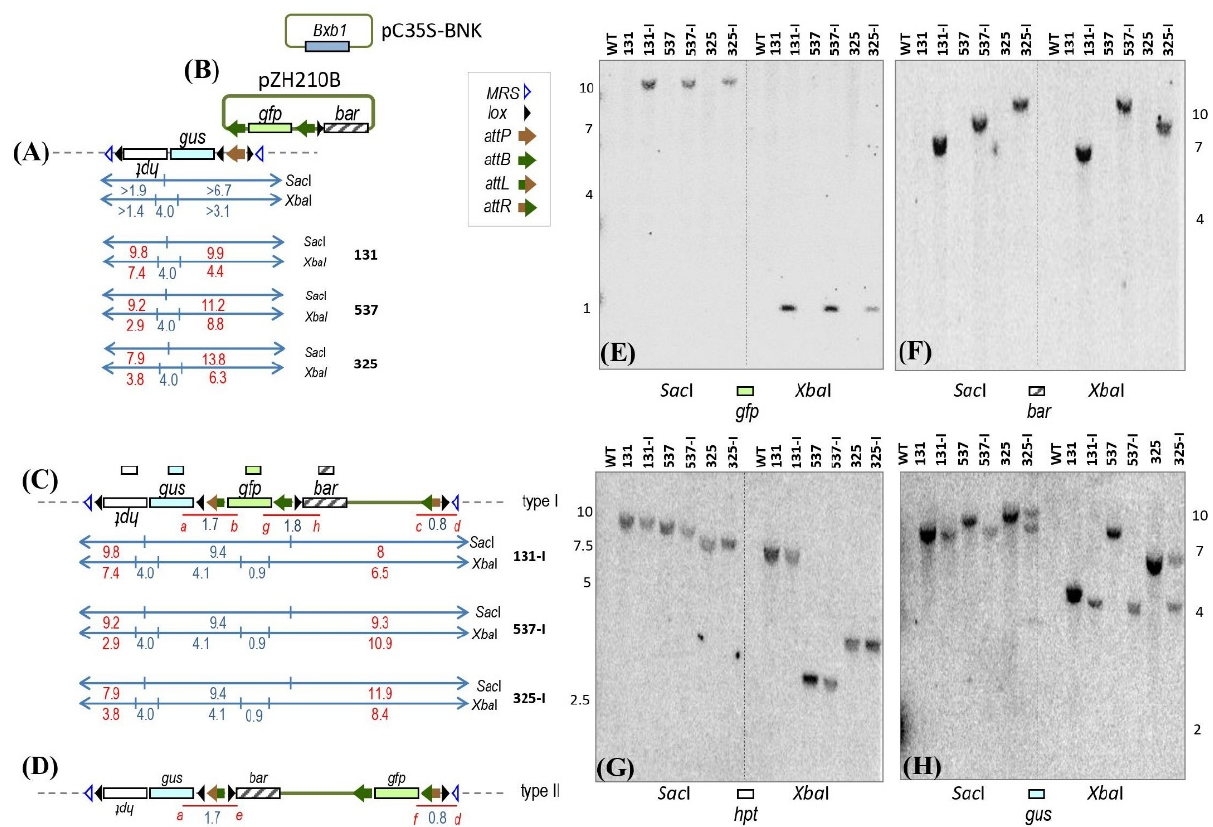
Figure 2. Structure of T1 target and T0 integrant lines. Not-to-scale depiction of recombination between genomic attP in rice target line ( A ) and either the gfp -upstream attB or the gfp -downstream attB in pZH210B ( B ) to produce the integrant structure in ( C ) or ( D ), respectively. Recombination catalyzed by co-transforming Bxb1 integrase-expressing construct pC35S-BNK. ( E – H ) Southern blots of SacI or XbaI cleaved genomic DNA probed with gfp , gus , hpt or bar as indicated. WT as in Figure 1; size markers on the side of each blot (based on ethidium-bromide-stained gels, not shown). Predicted border fragment sizes shown in red lettering were calculated from the nearest chromosomal SacI or XbaI; genes as in Figure 1 except gfp encoding green fluorescent protein and bar for bialaphos resistance; fragment sizes in kb; red lines represent PCR products.